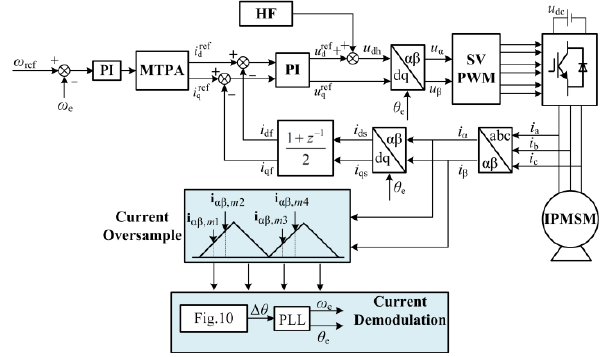
Figure 11. Block diagram of the proposed high-frequency signal injection method.